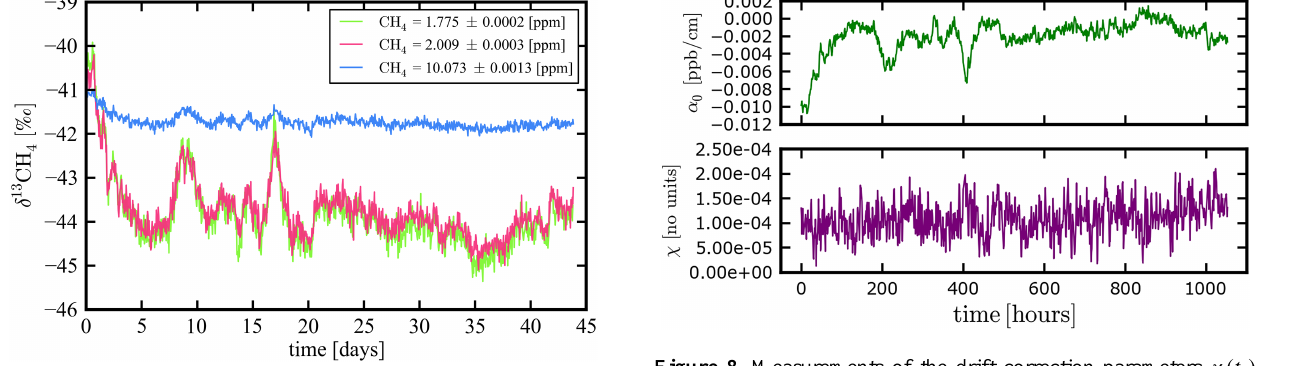
Figure 7. Measured isotope ratio on three bottles, HI (10.1ppm CH 4 and δ 13 CH 4 = − 41 . 7‰, blue line), LO (1.78ppm and δ 13 CH 4 = − 44 . 5‰, green line), and Target (2.01ppm, unknown isotope ratio, red line).